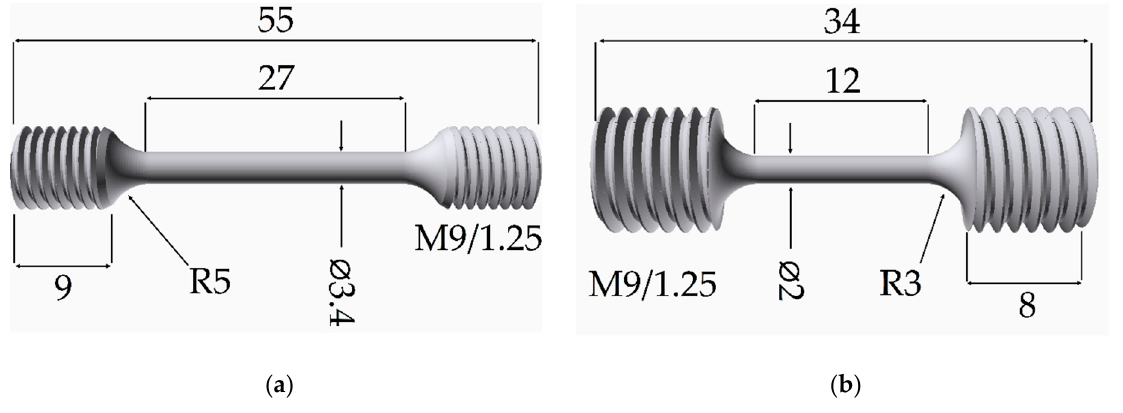
Figure 1. TCD specimen ( a ) and Far-Field Diffractometry specimen ( b ).